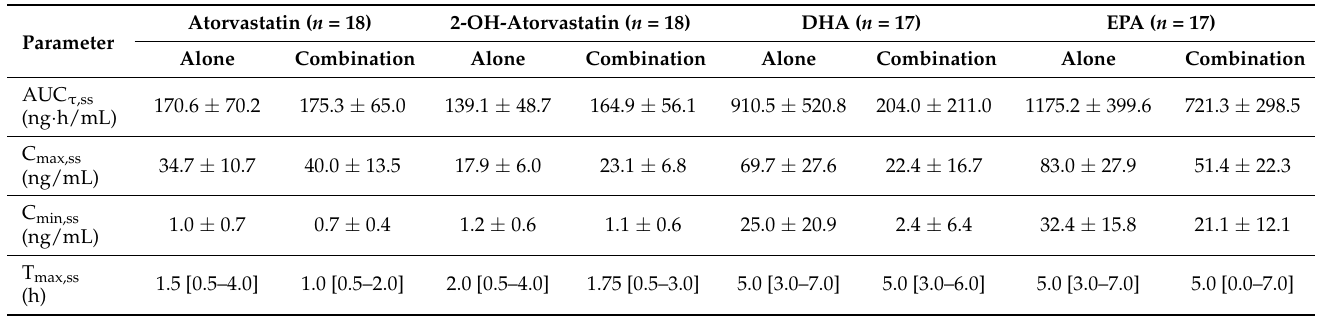
Table 2. Pharmacokinetic parameters for atorvastatin, 2-OH-atorvastatin, DHA, and EPA after single drug administration or co-administration.